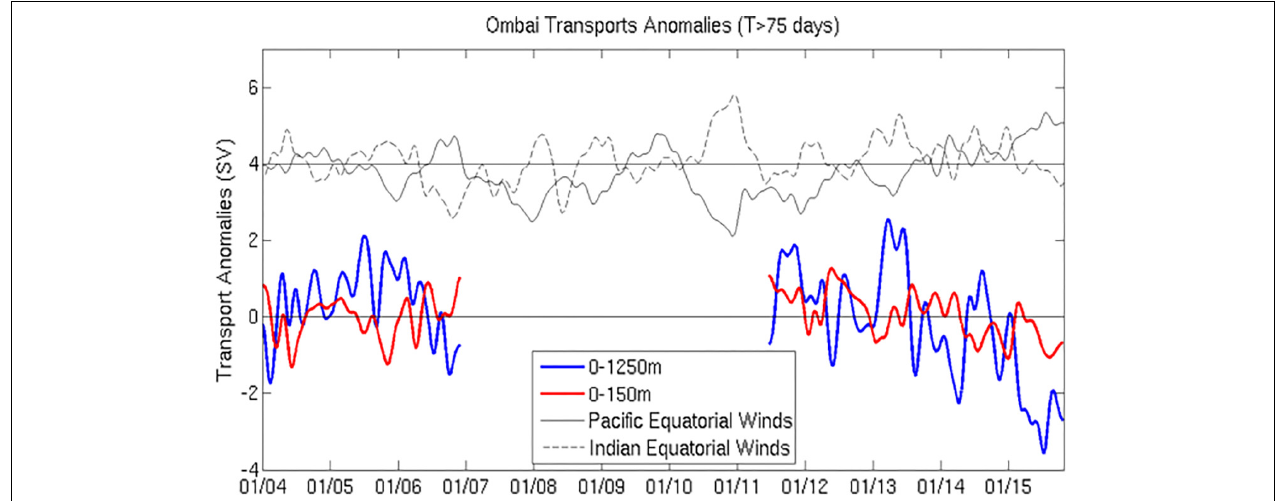
FIGURE 6 | Interannual (T > 75 days) time series of Ombai Strait transport anomalies from INSTANT (2004–2006) and IMOS ITF (2011–2015) for depth ranges 0–150 m (blue) and 0–1250 m (red). Also shown are the normalized zonal equatorial Pacific (solid) and Indian (dashed) Ocean winds from 2004 to 2015. Negative winds anomalies reflect stronger westerly trades winds over the equatorial region (Data from Wijffels et al., 2018).